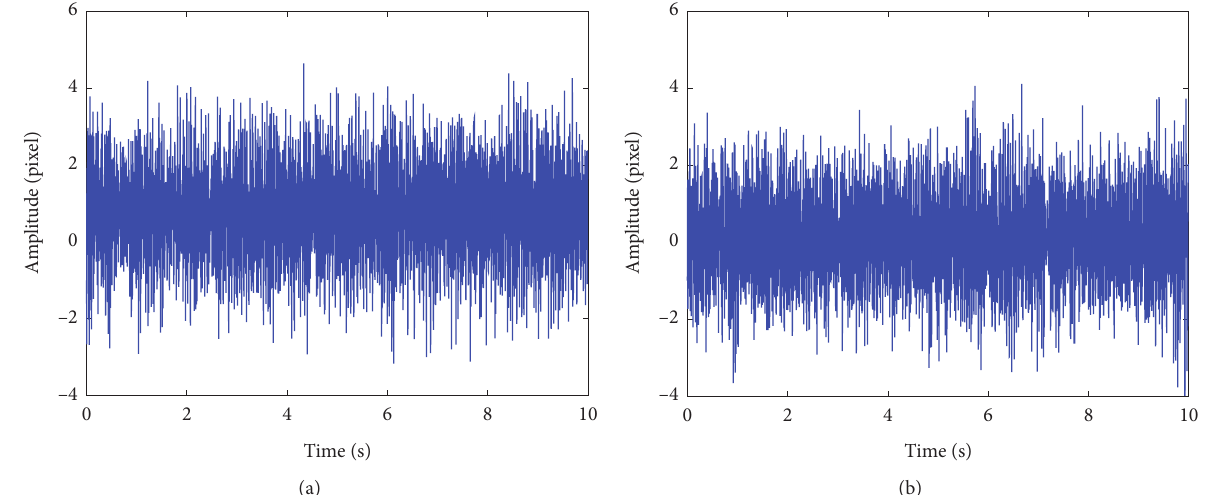
Figure 7: Vibration pixel displacements at P1. (a) Pixel displacement for the undamaged structure. (b) Pixel displacement for the structure of bolt B2